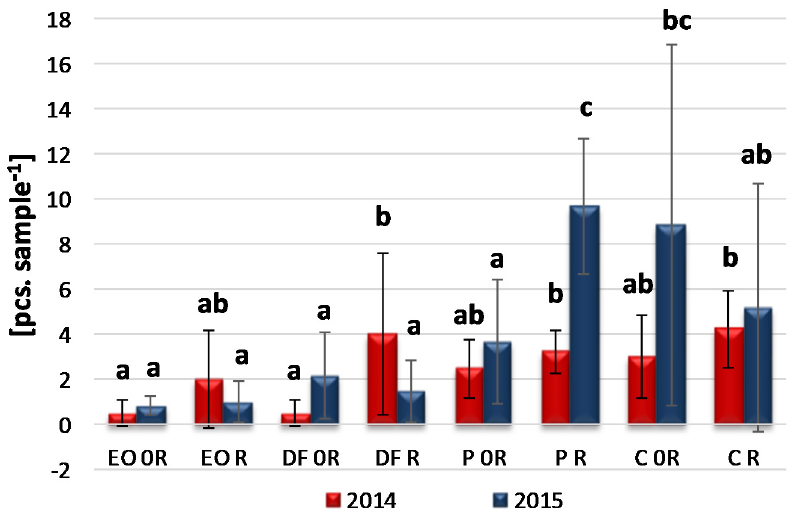
Figure 5. Occurrence of soil invertebrates (pcs. sample − 1 ). Mean values marked with the same letters for each year separately do not differ significantly according to the LSD test at p < 0.05. Symbols are the same as those used in Figure 1. Vertical bars show mean ± SE.